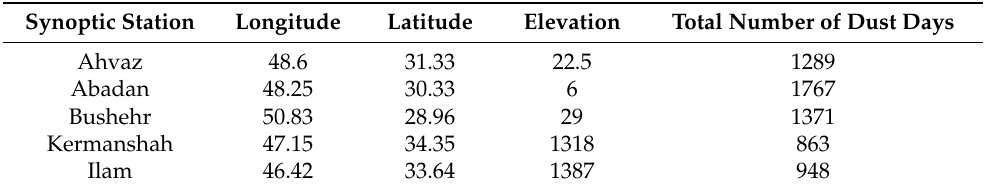
Table 1. The selected meteorological stations in southwest Iran and total number of dust days during